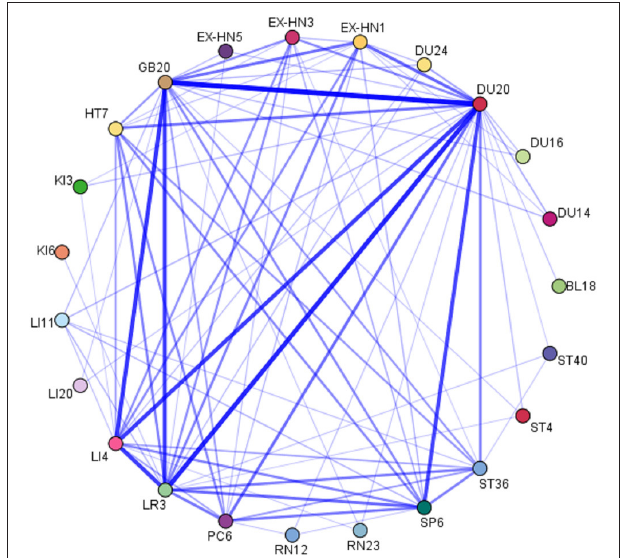
FIGURE 8 | Tree chart of the cluster analysis of acupuncture for TDs.